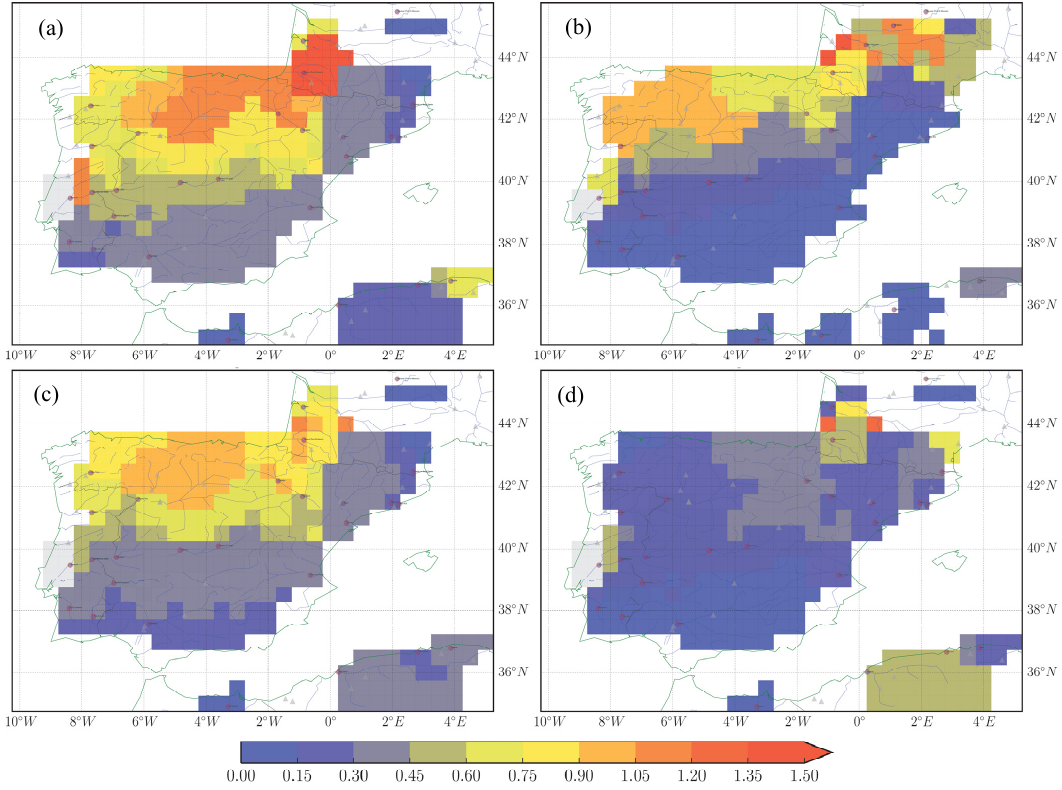
Figure 8. The correction factor x obtained from Y1SP0 forced by (a) WFDEI_CRU, (b) CRU_NCEP, (c) WFDEI_GPCC and (d) the “Uncertainty” (defined by Eq. 10) of x by different forcing. All values are averaged over the period